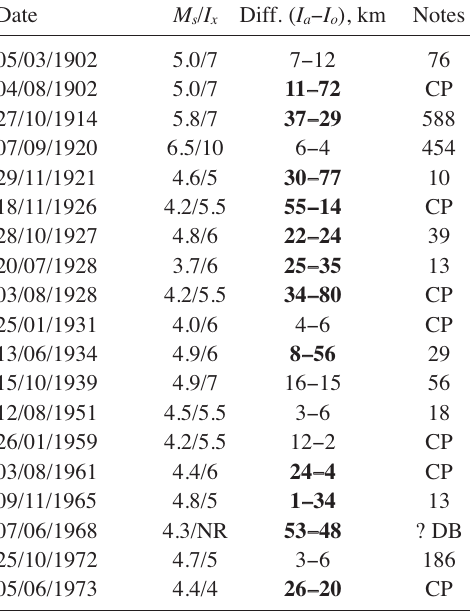
Table III. Absolute differences (in km) between the latitude and the longitude of the macroseismic and instrumental locations. Bold numbers are used when the differences exceeds 16 km for any of the values. The magnitude is taken from the NT4.1.1 Catalogue. The last column of the table displays the number of points of intensity available for the macroseismic lo- cation. CP indicates the events extracted from other catalogues: for these events no quality information can be